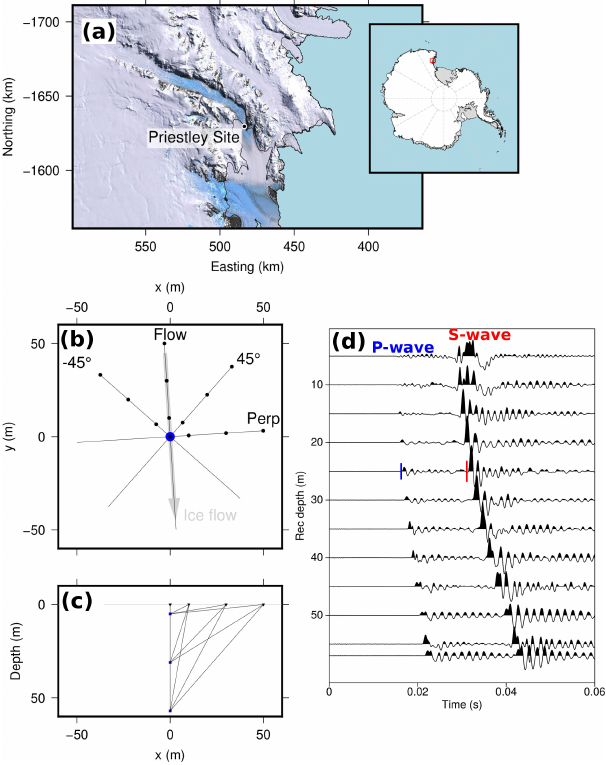
Figure 1. (a) Regional map of the Priestley Glacier site. Coordi- nates are given by the polar stereographic projection with latitude of true scale at − 71 ◦ S. Landsat image courtesy of USGS. (b) Map view illustration of VSP geometry. Black markers show shotpoint locations; the borehole location is shown in blue. (c) Cross-section illustration of VSP geometry showing the surface shotpoints in black and three borehole seismometer positions in blue. Lines con- necting sources and receivers indicate seismic ray paths. (d) Vertical component traces of borehole seismometer for shots at 50m offset along the 45 ◦ profile. Example P- and S-wave arrival time picks are shown at 25m depth as vertical blue and red